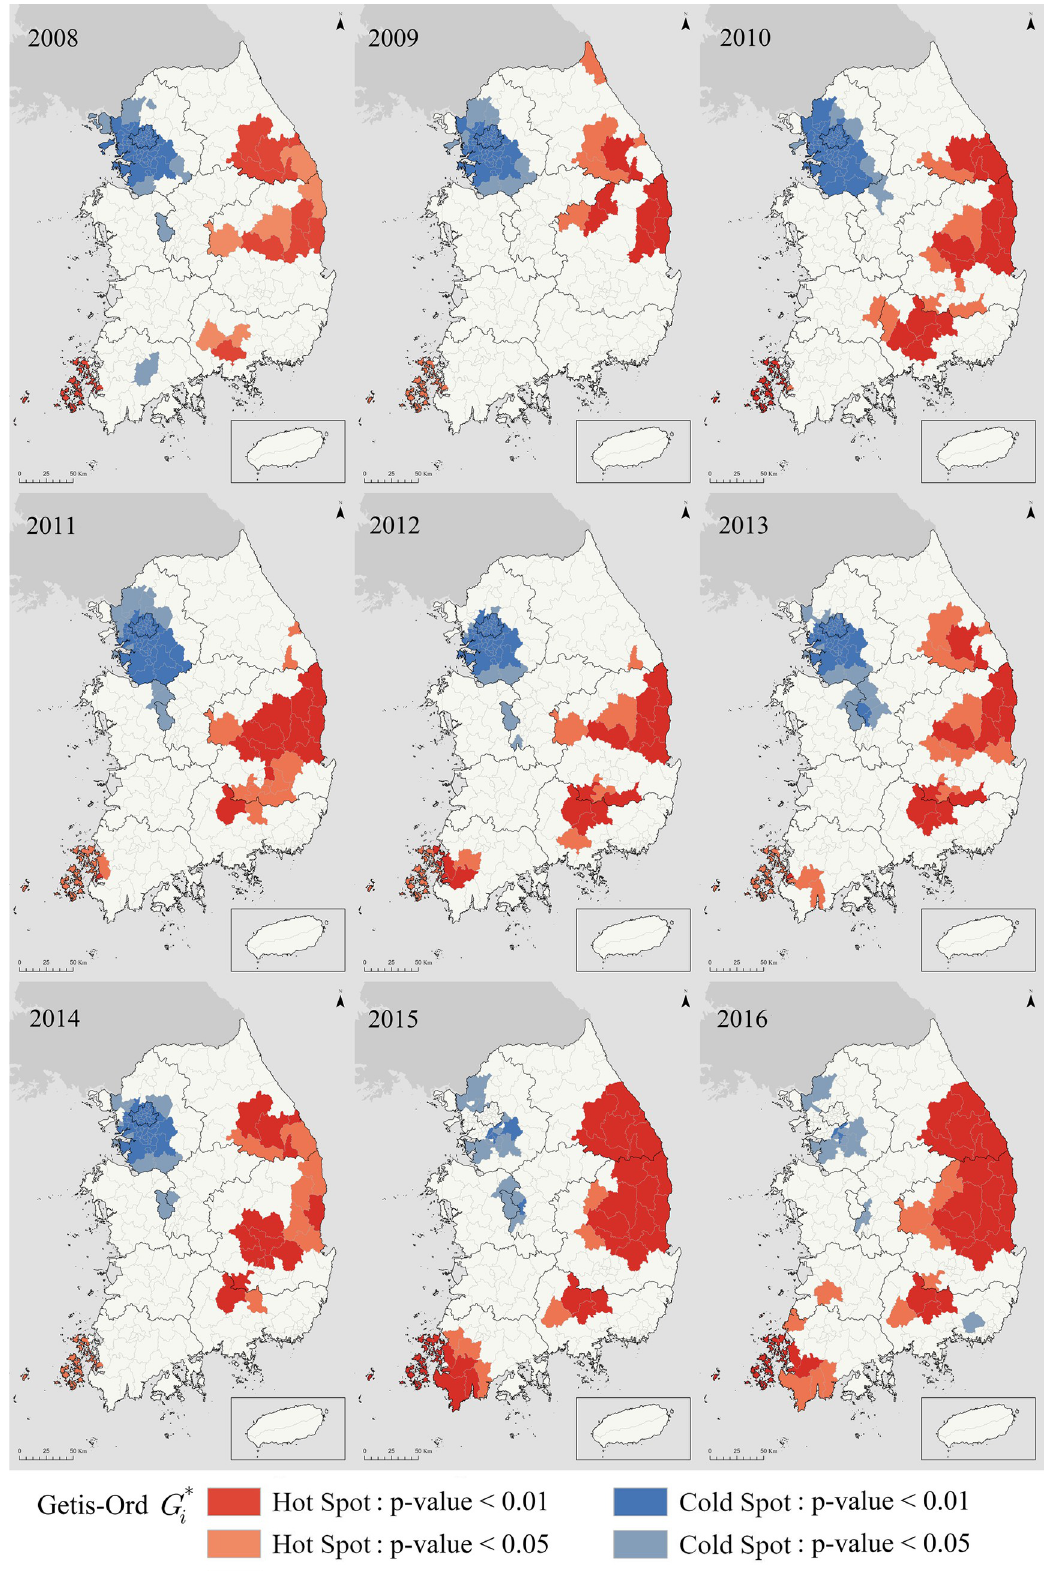
Fig 4. Spatial patterns of TB hotspot and coldspot